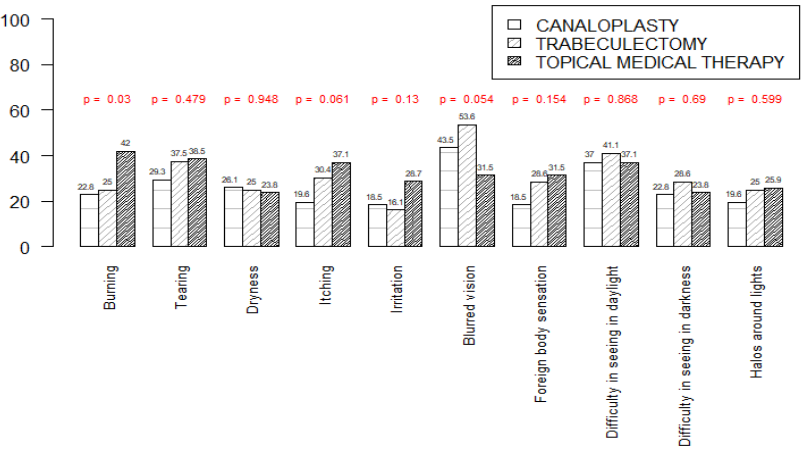
Figure 4. Incidence of the 10 symptoms analyzed by Glaucoma Symptom Scale (GSS) questionnaire in the three treatment groups. p -values resulting from the G-test are reported on the top of the columns.